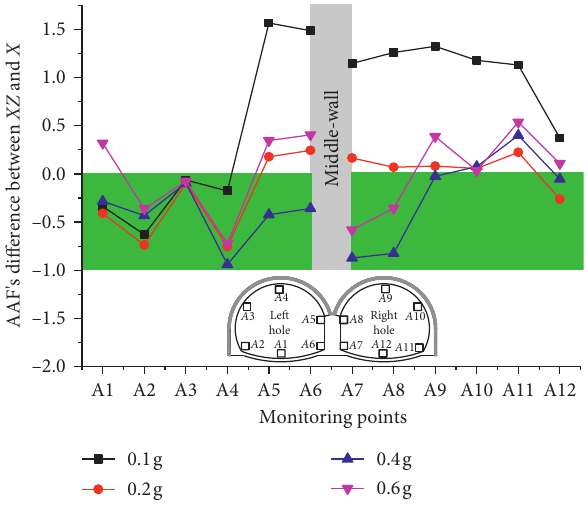
Figure 14: The difference between the vertical AAF of WC-XZ and